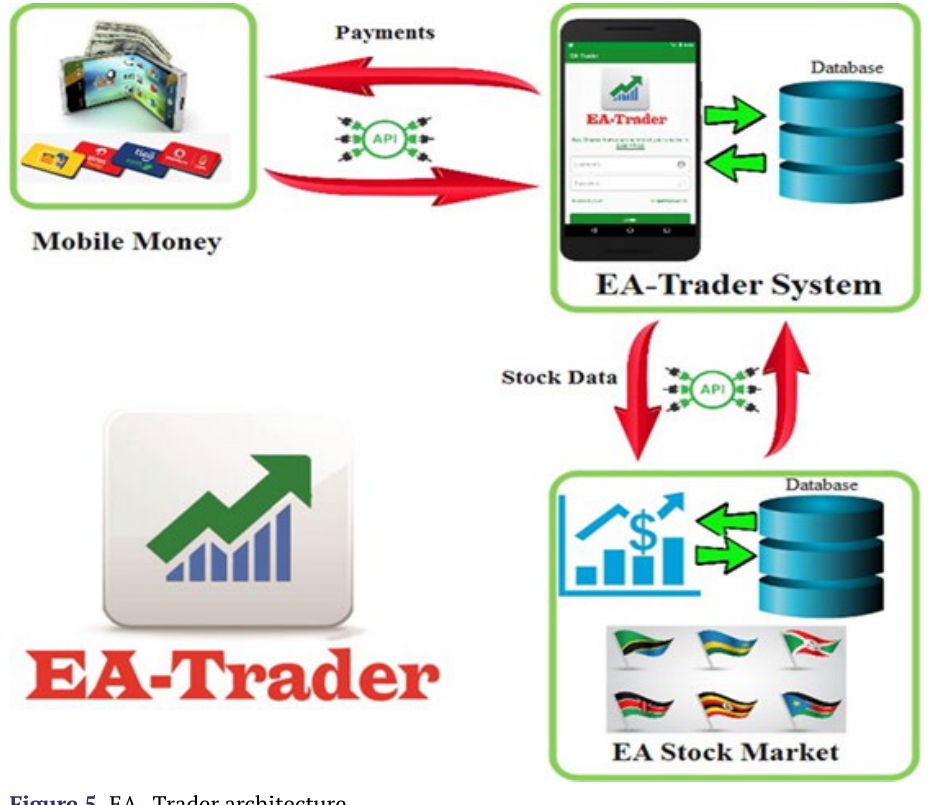
Figure 5. EA- Trader